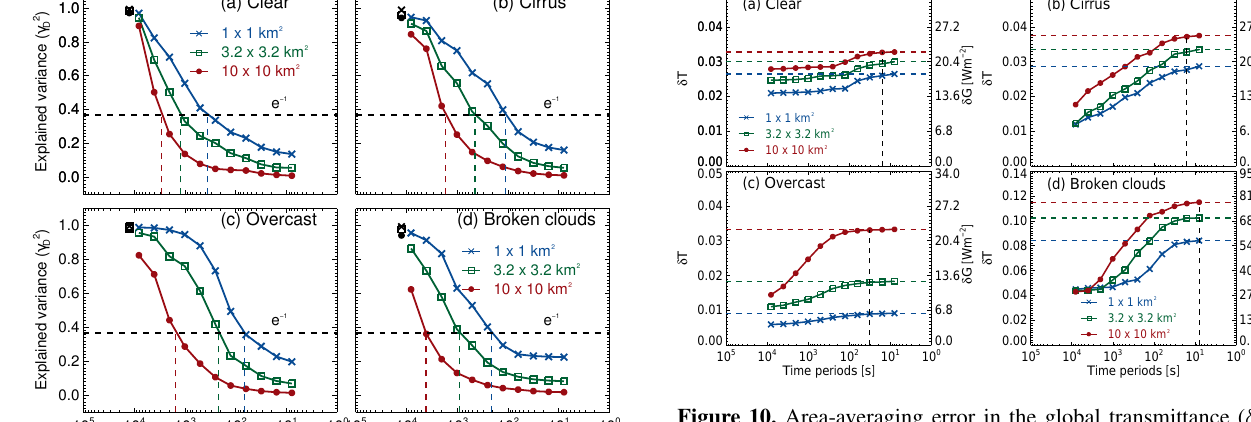
Figure 10. Area-averaging error in the global transmittance ( δT ) and corresponding global radiation ( δG , in Wm − 2 ) with different sky conditions: (a) clear, (b) cirrus, (c) overcast, and (d) broken Figure 9. Explained variance ( γ 2 , the square of the cross- clouds for different domain sizes represented as a function of av- D correlation) between the wavelet details of the point measurement eraging time periods. The dashed horizontal lines correspond to the and the area-averaged values of global transmittance as a function maximum deviation observed for the different domain sizes. Dashed of their time period and for different domain sizes and sky condi- vertical lines represent the minimum-averaging time above which tions: (a) clear, (b) cirrus, (c) overcast, and (d) broken clouds. The the area-averaging errors are less sensitive at different spatial reso- black symbols respectively denote the explained variance ( γ 2 ) of S 3 wavelet smooths S 3 (3h) corresponding to the domain size. The black dashed horizontal line in each of the sub-figures represent the e -folding time of e − 1 = 0 . 368 and the dashed vertical lines corre- sponds to the decorrelation period for the selected domain sizes.